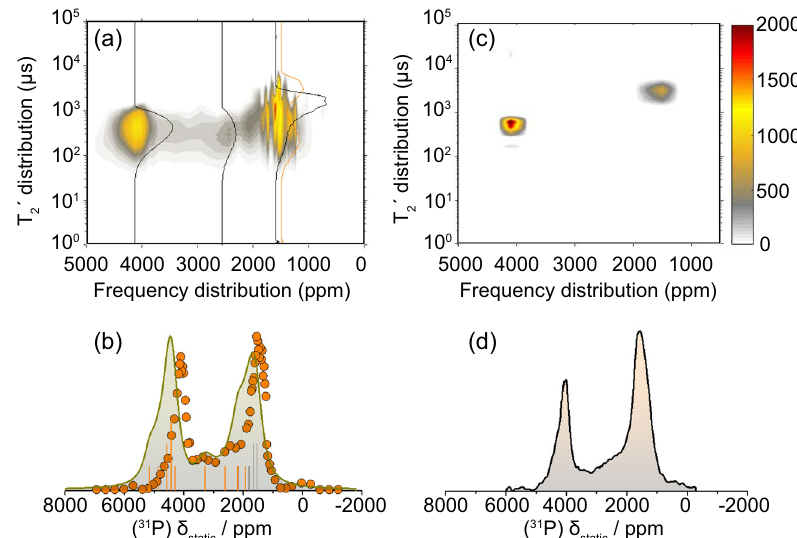
-- Fig. 7 31 P NMR T 0 dephasing analysis combined with DFT-calculated NMR showcasing the dominance of the ð 10 10 Þ facets by increasing the size of 2 . distribution as a function of the shift for the 12 nm nanocrystalline Ni 2 P. Black cross-sections are representative T 0 the nanoparticles. a The 31 P NMR T 0 2 2 distributions at speci fi c shifts which, for better visualization have rescaled intensities. b DFT-calculated 31 P NMR spectrum (olive color line). The orange color lines are the isotropic resonances of P(1) sites, and gray lines are the isotropic resonances of P(2) sites. Orange color circles are the signal intensities calculated by inverting the CPMG spin-echo decays. c The 31 P NMR T 0 distribution as a function of the NMR frequency shift for microcrystalline (bulk) 2 Ni 2 P. d The experimental 31 P ssNMR spectrum of the nanocrystalline